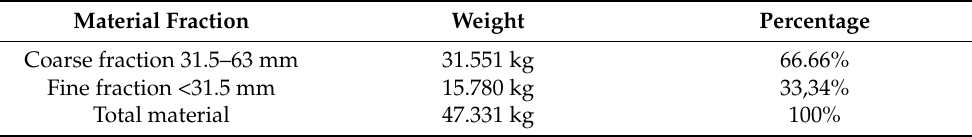
Table 4. Total weight of ballast material categorized as fine and coarse material for sample #2.